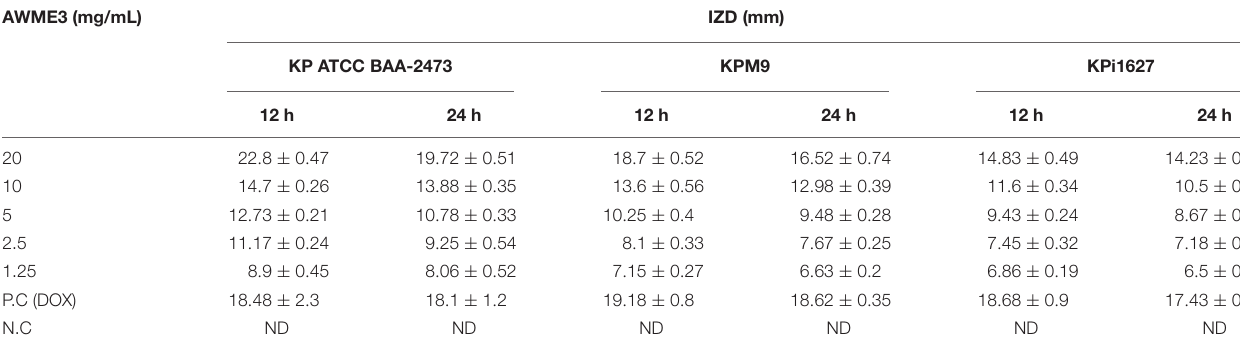
TABLE 2 | Inhibition zone diameters (IZDs) caused by the AWME3 of H. illucens larvae fat against K. pneumoniae strains. AWME3 (mg/mL) IZD (mm)